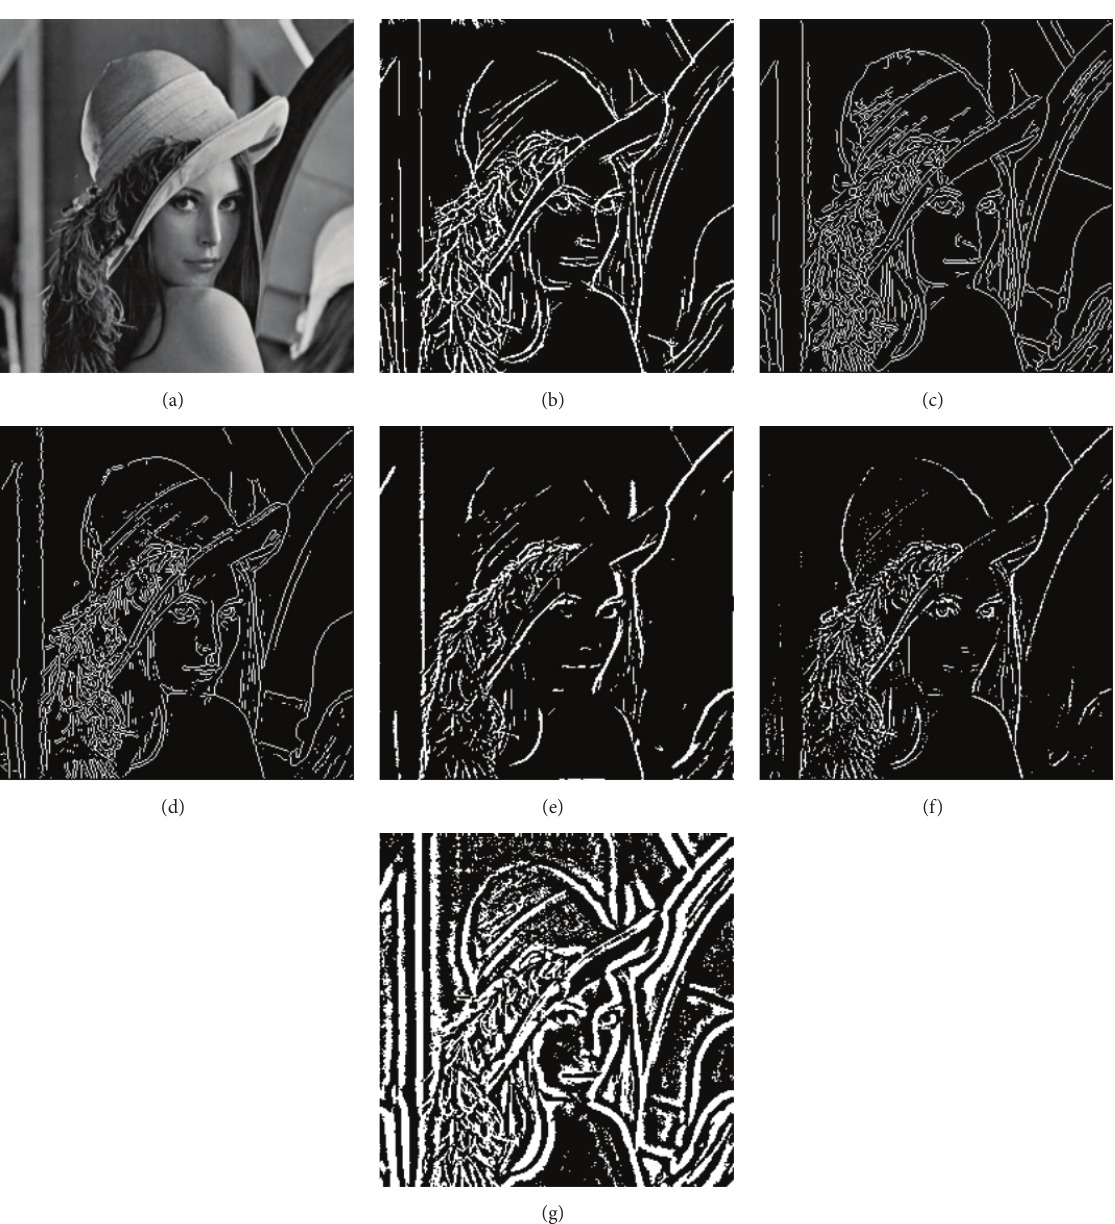
Figure 6: Edge detection results: (a) original image; (b) the result by Canny; (c) the result by our method; (d) the result by Sobel; (e) the result by wavelet method; (f) the method based on CNN; (g) NSCT